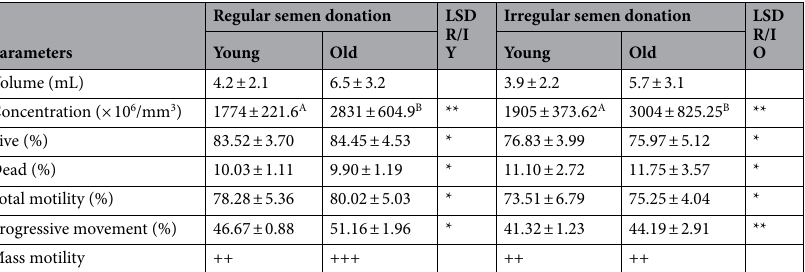
Table 8. Semen quality parameters of young and old bulls during regular and irregular sperm donation (mean ± SD). Explanation: Values with different letters (a, b) differ significantly between columns at P < 0.05, * P < 0.05; ** P <